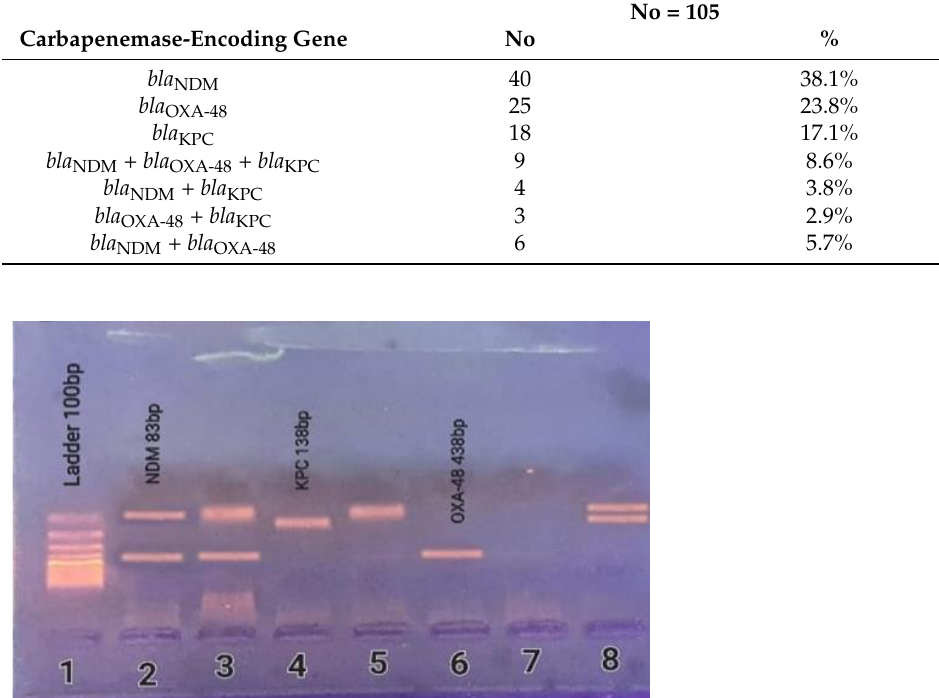
Table 5. Genetic profile of CRKP isolates.